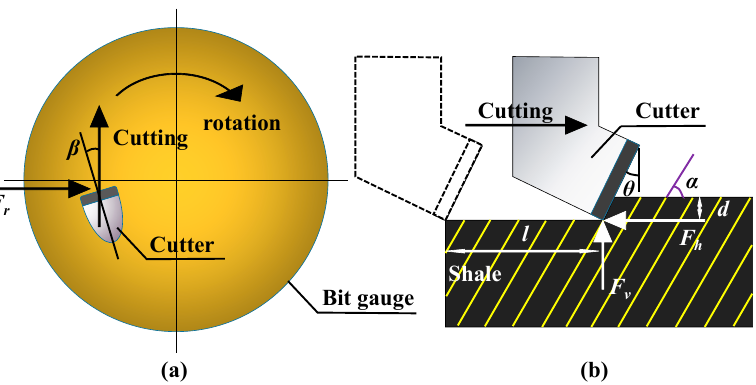
Figure 4. Interaction model between a PDC cutter and shale. ( a ) Diagram of cutter path, cutting direction and lateral force; ( b ) force model of cutter (modified based on [95]).